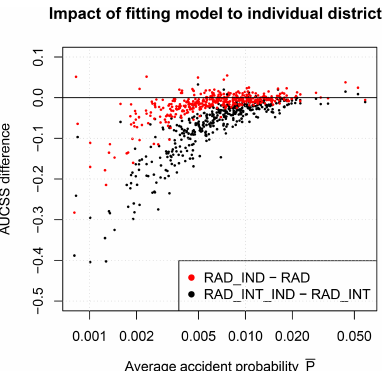
Figure 3. Differences in area under receiver operating charac- teristic curve skill score (AUCSS) values between the models RAD_IND and RAD (red) and RAD_INT_IND and RAD_INT (black). AUCSS differences are shown for each of the 401 adminis- trative districts vs. the average accident probability P of the respec- tive districts (dots).